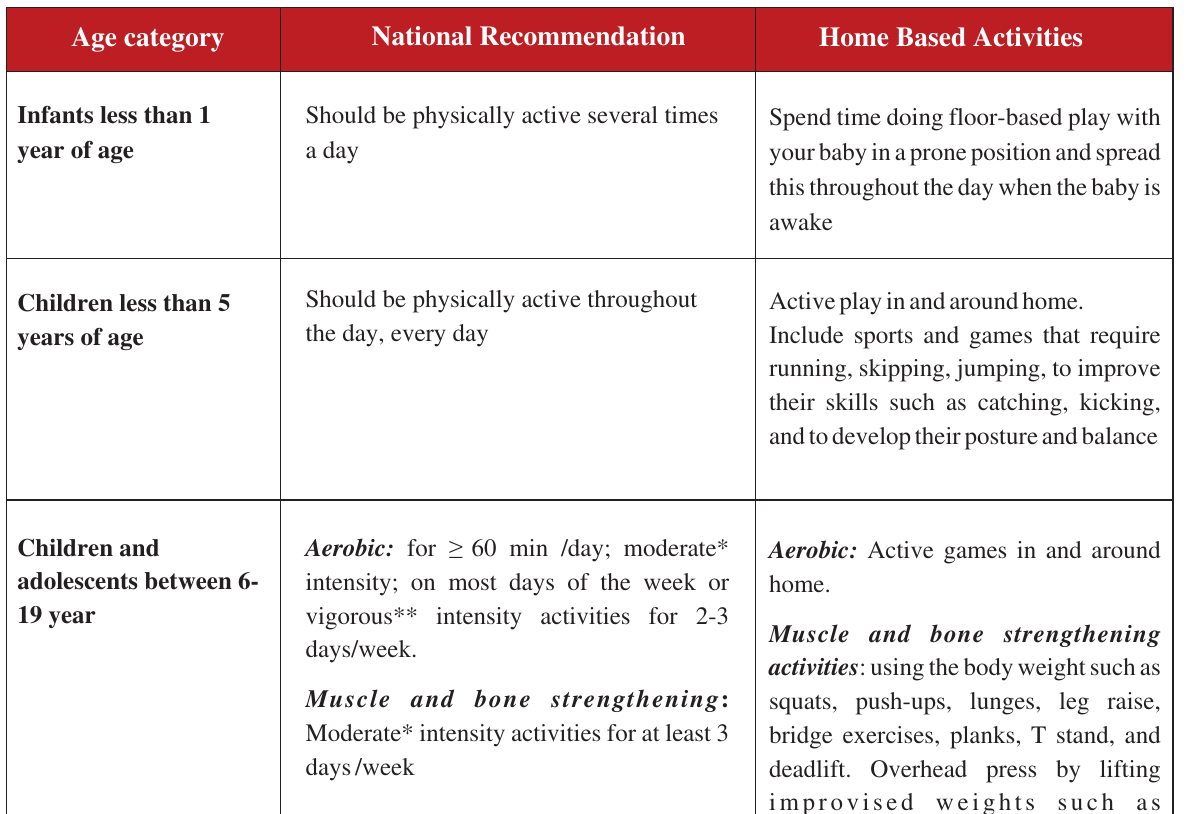
Table 1: National recommendations and examples of home-based physical activities for different age